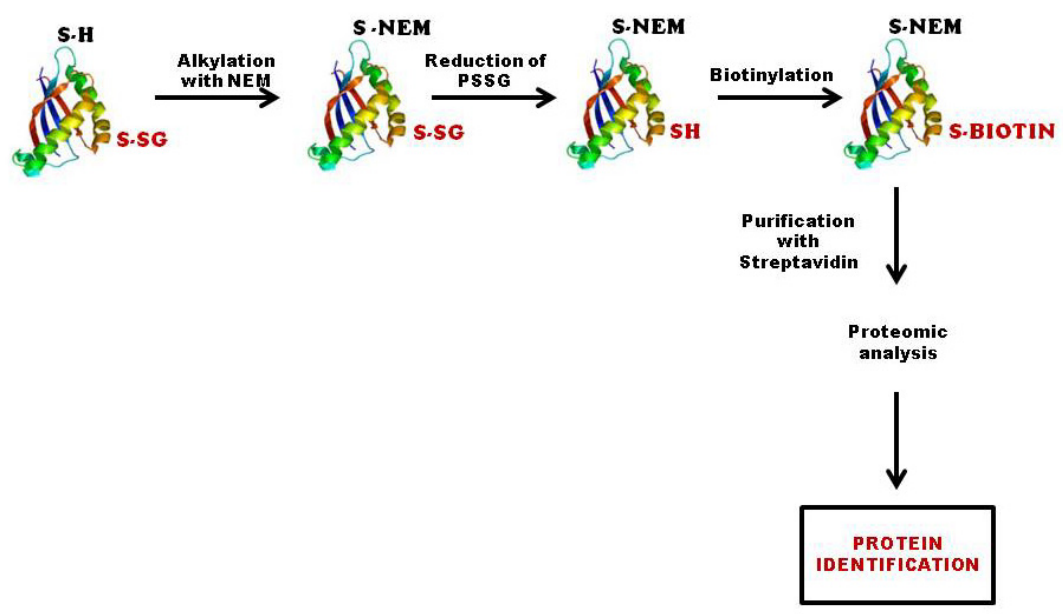
Figure 4. Detection of glutathionylated proteins by biotin labeling. Proteins are first alkylated with N -ethylmaleimide to block free sulfhydryls. Oxidized sulfhydryls are then reduced with Grx3 and labeled with biotin. Biotin-labeled proteins are affinity purified on avidin-conjugated agarose beads. After extensive washing with detergent buffer, proteins bound to avidin via a mixed disulfide bond with biotinylated glutathione can be eluted by incubation with reducing agents (DTT or β -mercaptoethanol), separated on two-dimensional sodium dodecyl sulfate polyacrylamide gel electrophoresis (2D SDS PAGE) and subjected to proteomic